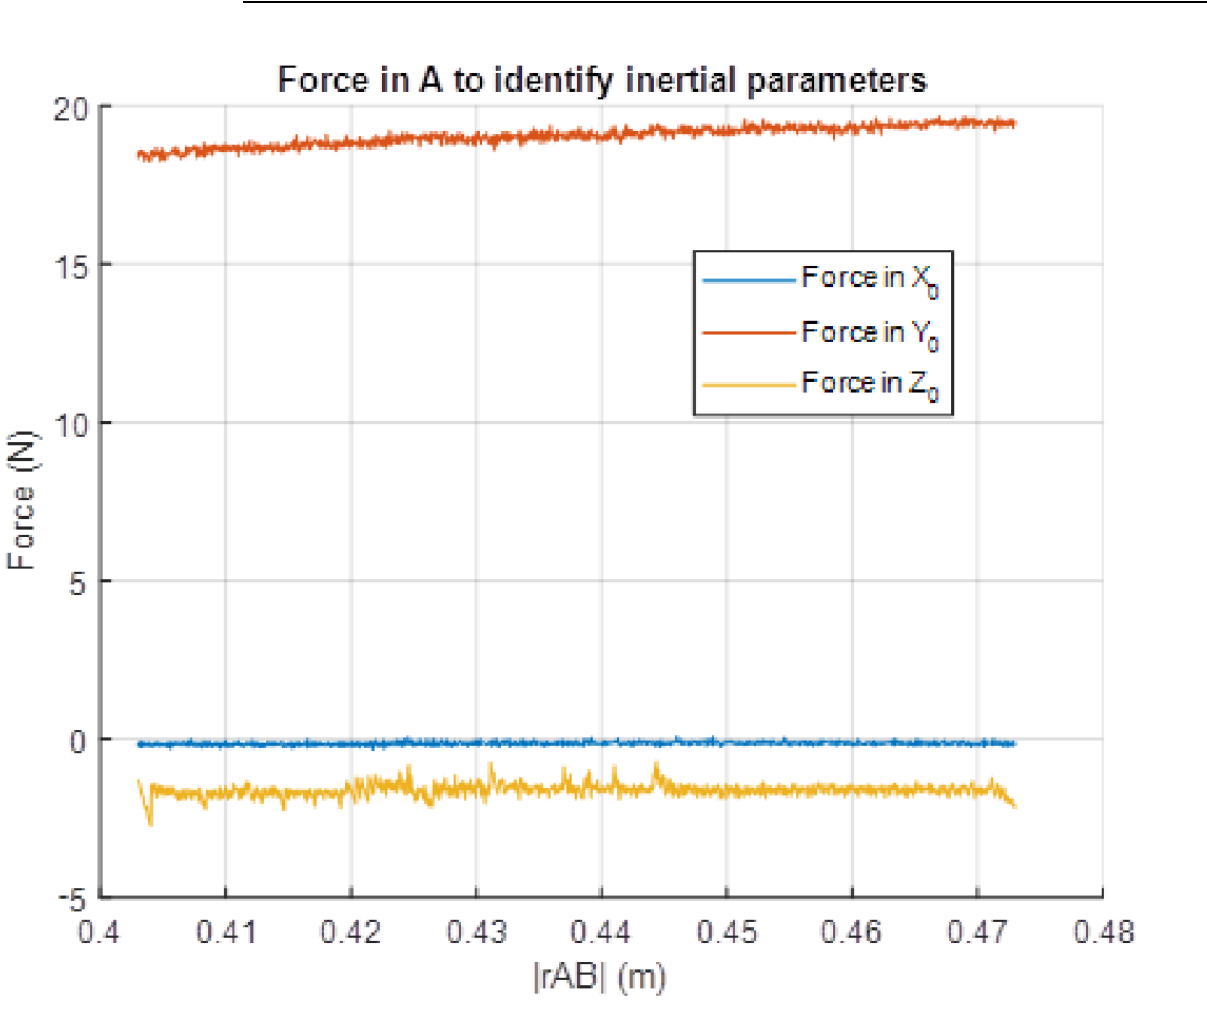
Table 2. Results of the identification of manipulators.